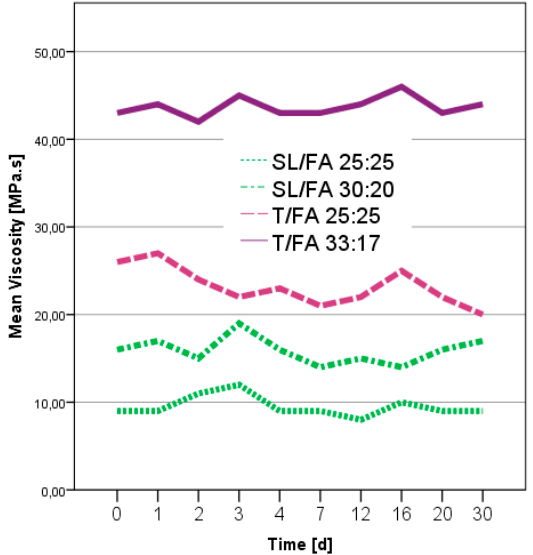
Figure 1. Viscosity trend of spent-liquor/furfuryl alcohol and tannin/furfuryl alcohol formulations. The viscosities of every furfuryl alcohol-based formulations with different ratios of spent liquor/FA and tannin/FA showed no significant modifications within the first 30 days of storage.